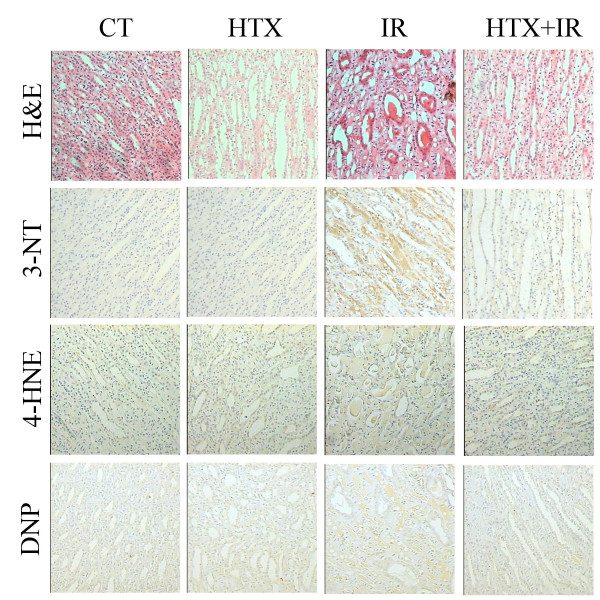
Representative images of histology (H&E) (first row) and immunohistochemical detection of 3-NT (second row), 4-HNE (third row) and DNP (fourth row) in renal medulla of the four groups of rats studied: CT, HTX, IR, and HTX+IR. (100× magnification).